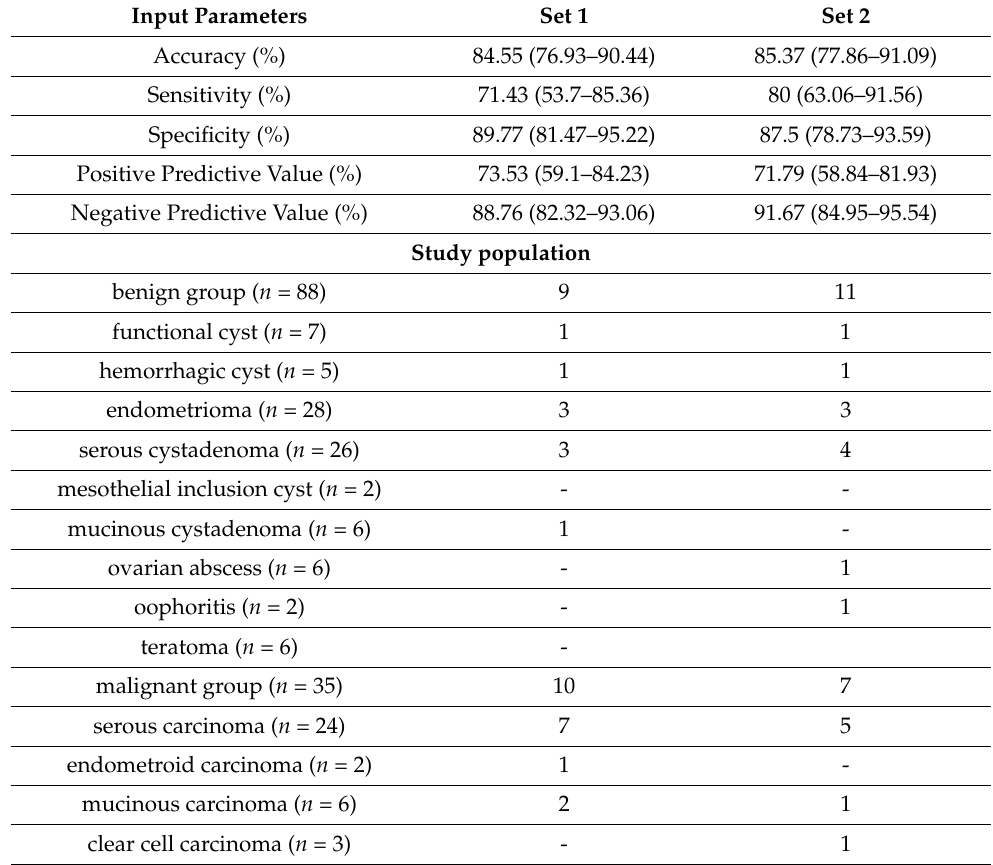
Table 4. The k-nearest neighbor classifier’s results. The values between the brackets corresponding to the 95% confidence interval. KNN, k-nearest neighbor classifier.